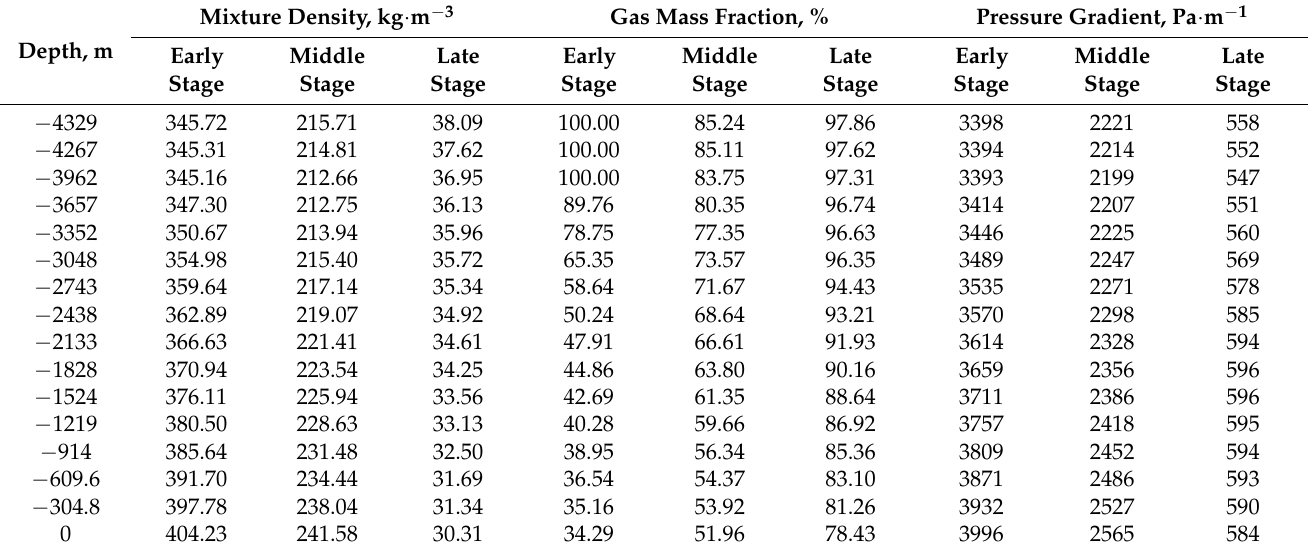
Table 7. The changes in physical properties, gas content and pressure gradient at different stages.